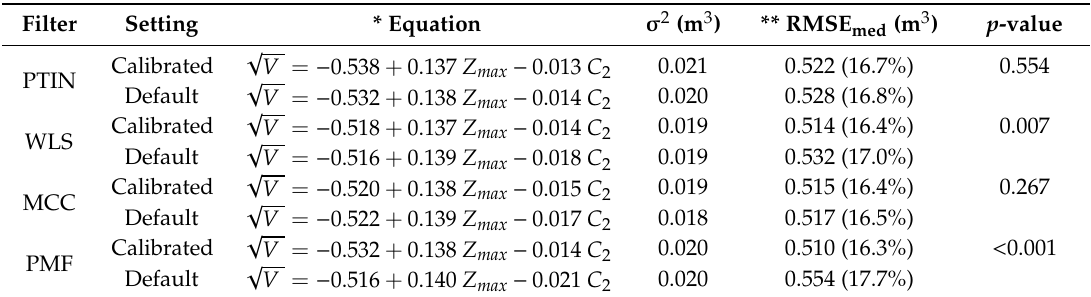
Table 6. Volume equations with their associated variances ( σ 2 ), and the p -value for the Wilcoxon–Mann–Whitney test obtained with di ff erent settings of the progressive triangulated